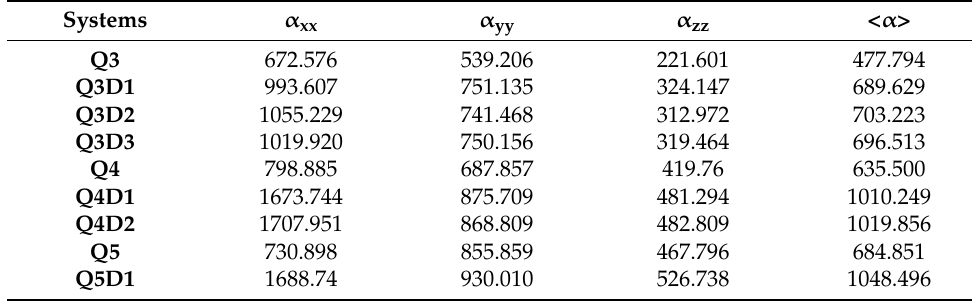
Table 3. Dipole polarizabilities and major contributing tensors (a.u.) of Q3 – Q5D1 .